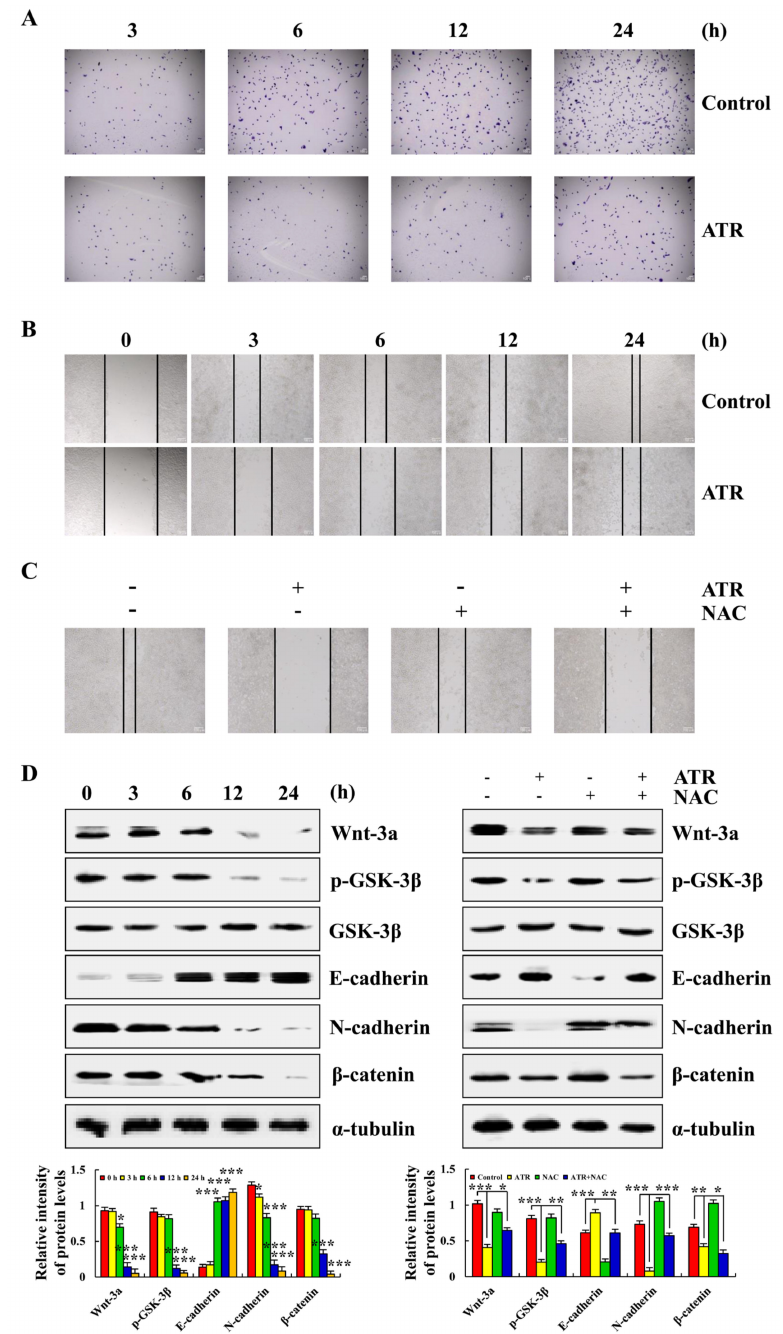
Figure 6. Effects of ATR on migration of A549 cells. A549 cells treated with 38 µ M ATR for 3, 6,